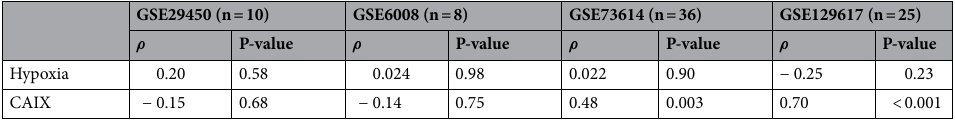
Table 1; GSE73614, ρ = 0.48, p = 0.003; GSE129617, ρ = 0.70, p < 0.001). In contrast, the coefficients for this